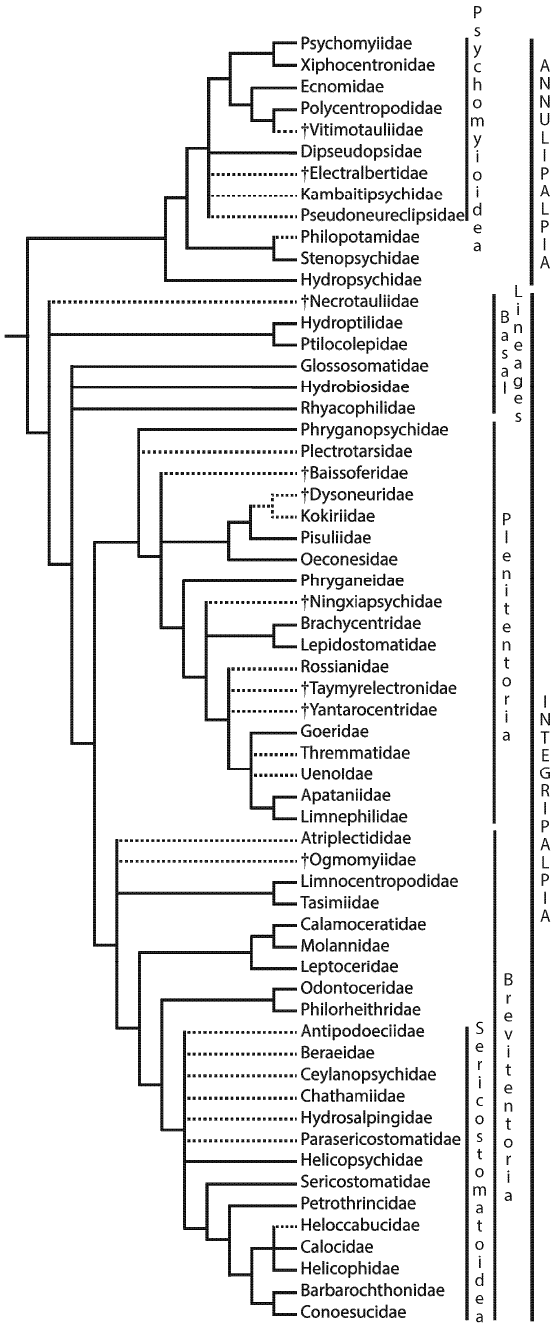
Figure 2. Phylogeny of extinct ( † ) and extant Trichoptera families. Solid lines refer to relationships inferred with molecular data by Kjer et al. [67] with some refinements [69,70]. Dashed lines refer to relationships inferred by other data (mostly morphological) from various sources: † Vitimotauliidae [71,72], Dipseudopsidae [73], † Electralbertidae [74], Kambaitipsychidae [75], Pseudoneureclipsidae [75], Philopotamidae [73], † Necrotauliidae [76,77], Plectrotarsidae [73], † Baissoferidae [72], † Dysoneuridae [78], Kokiriidae [73], † Ningxiapsychidae [79], Rossianidae [73], † Taymyrelectronidae [80], † Yantarocentridae [8], Thremmatidae [81], Uenoidae [73], Atriplectididae [73], † Ogmomyiidae [9], Ceylanopsychidae [82], Antipodoeciidae [82], Beraeidae [82], Chathamiidae [73], Hydrosalpingidae [82], Parasericostomatidae [82], and Heloccabucidae [82]. Lengths of lines are arbitrary and